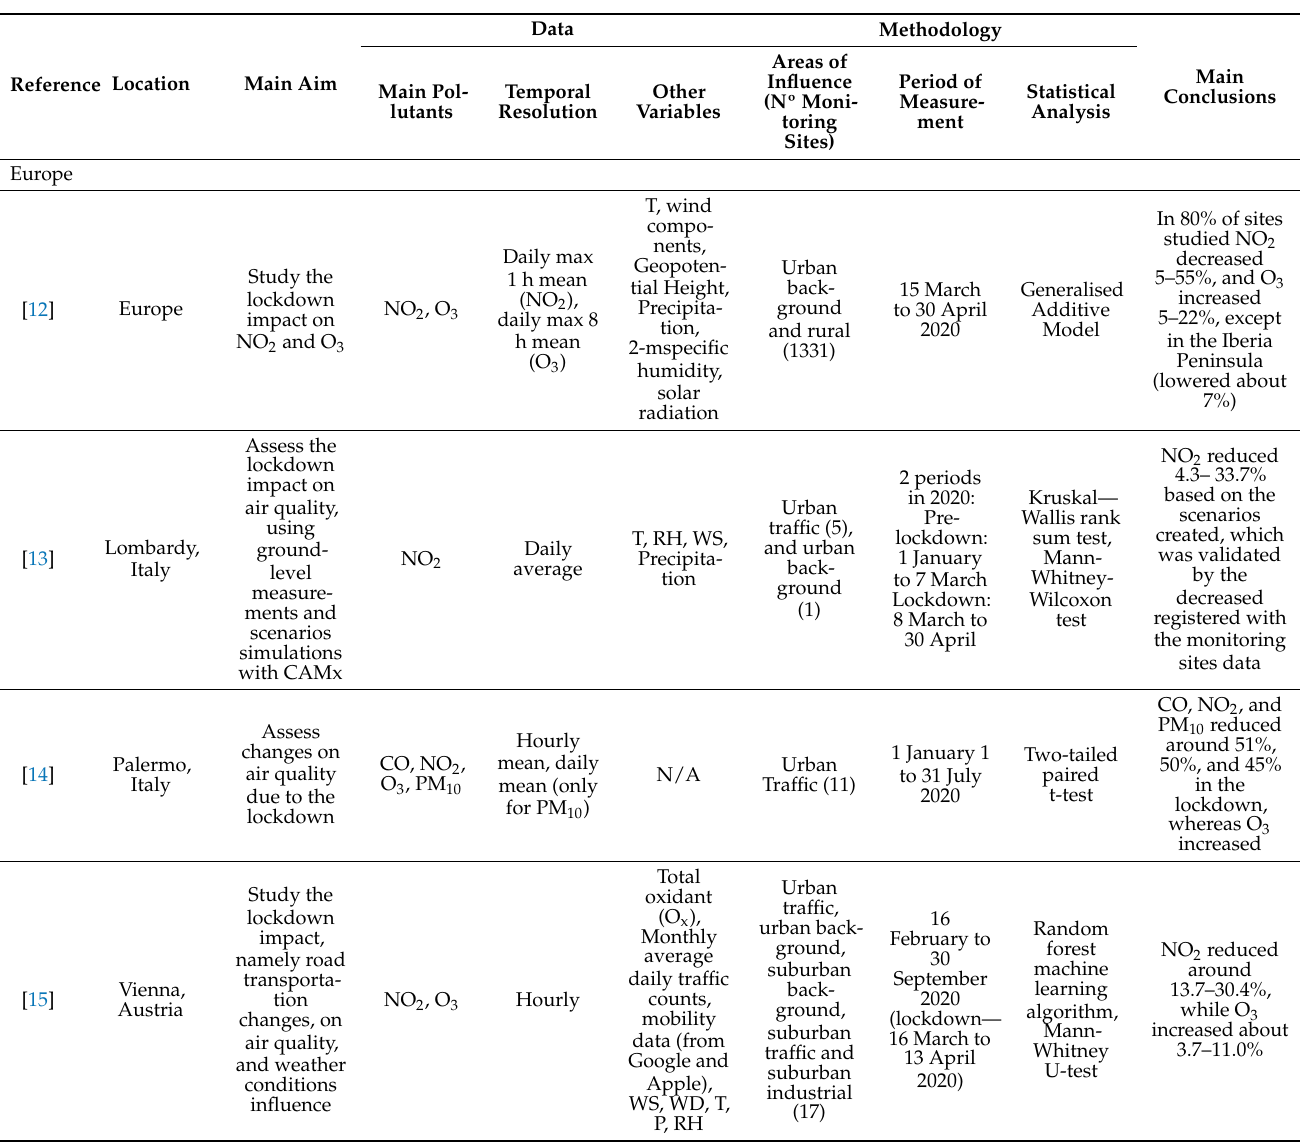
Table 1. Summary of the main characteristics of the 30 reviewed studies (that used as reference data an historical period of at least 5 years), namely reference, location studied, main objectives, data, methodology, statistical analysis, and